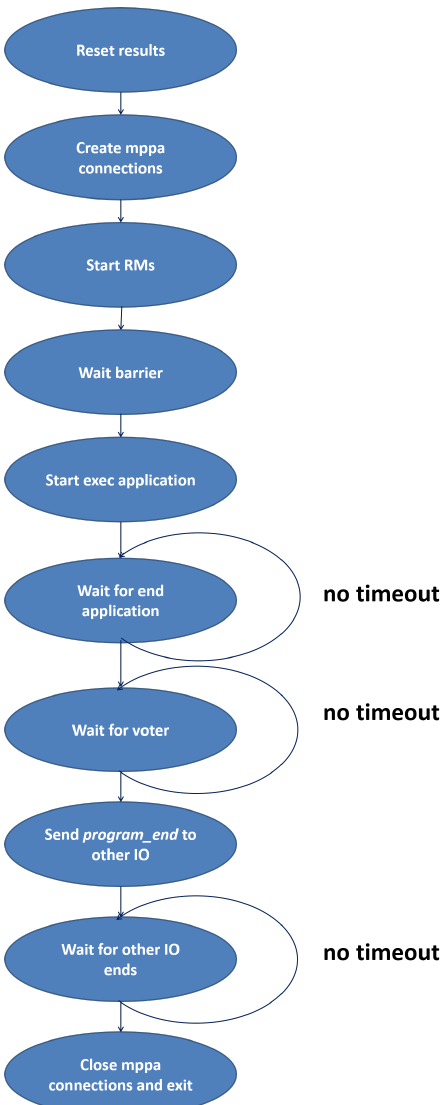
Figure A2. Flow diagram of the main function run in